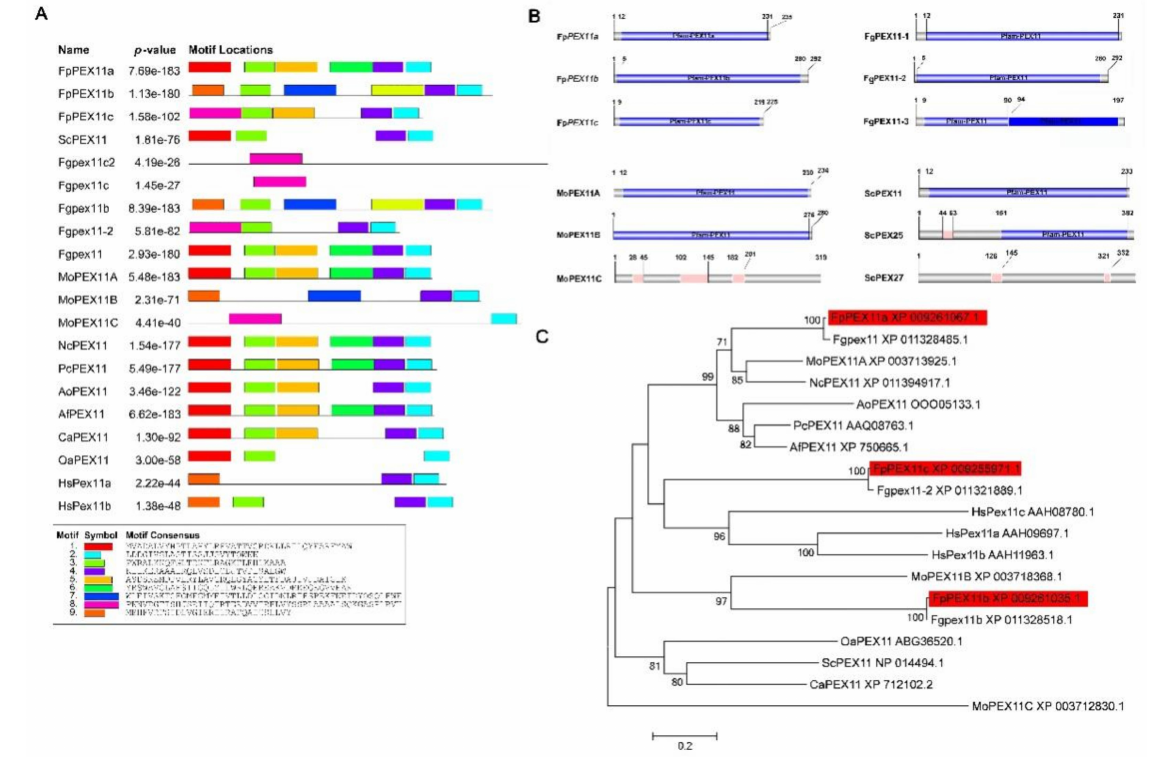
Figure 1. Bioinformatics analysis of PEX11 in F. pseudograminearum. ( A ) MEME analysis. ( B ) Domain analysis. ( C ) Phylogenetic tree. ( A ) FpPex11 contains conserved C-terminal motif as revealed